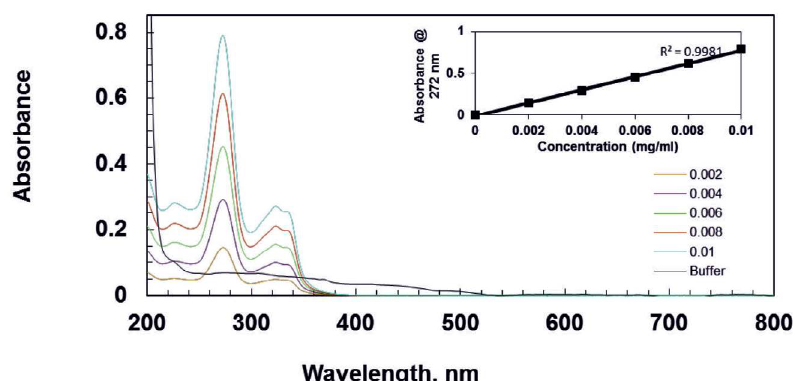
Fig. 3. Spectra of norfloxacin at different concentration.